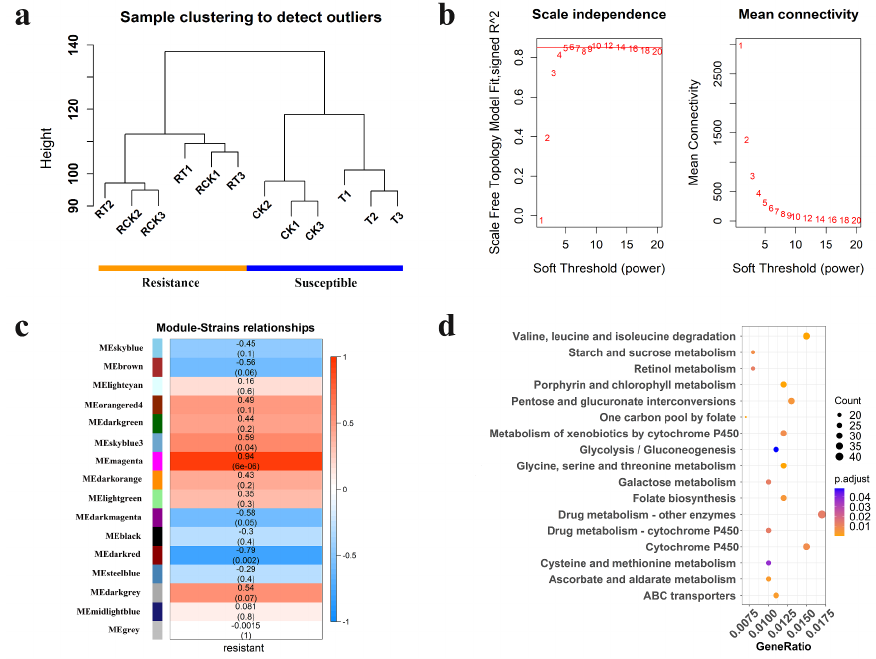
Figure 6. Weighted gene co-expression network analysis of 12 samples from two strains of Plutella xylostella . ( a ) Clustering dendrogram of 12 samples and the trait (resistance). RCK, Resistant stain without treatment by chlorantraniliprole (LC 50 ); RT, Resistant stain after treated with chlorantraniliprole (LC 50 ); CK, Susceptible strain without exposure to any insecticide; and T, Susceptible strain exposed to chlorantraniliprole (LC 50 ). ( b ) Analysis of the scale-free fit index for var- ious soft-thresholding powers ( β). ( c ) Heatmap of the correlation between module eigengenes and chlorantraniliprole-resistance (the color from blue to red ( − 1 → 1) represents the relationship be- tween module and trait). Each row corresponds to a module eigengene, and each column to a trait. Each cell contains the corresponding correlation and p -value. ( d ) KEGG pathway annotation clas- sification of genes in “magenta” and “darkred” module. The ordinate left is the KEGG pathway, and the abscissa is the ratio of genes enriched in the pathway. The size of the round spot repre- sents the number of genes enriched in the pathway, and the color represents the size of P adjust val- ue.